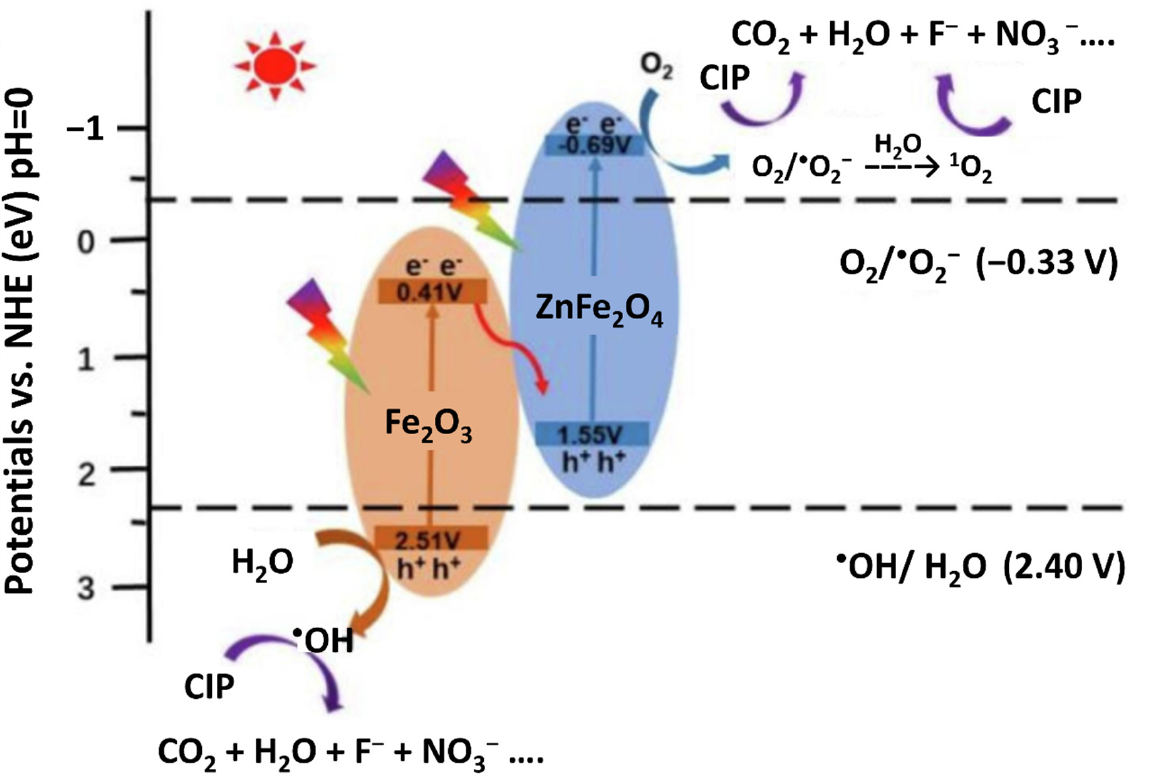
Figure 6. Z-scheme of photocatalytic CIP degradation system. Reprinted with permission from Ref. [99]. Copyright 2022 Elsevier.